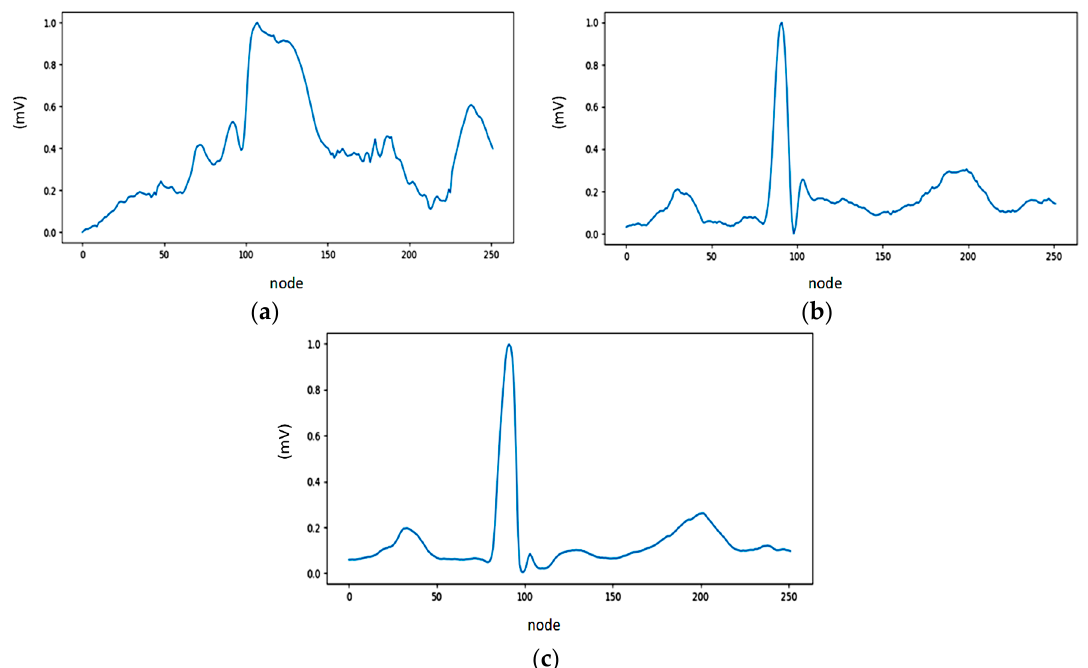
Figure 6. The sample of denoising autoencoders (DAEs)–autoencoders (AEs) process for ECG signal. ( a ) Noisy ECG Signal, ( b ) Target, ( c ) Reconstruction.